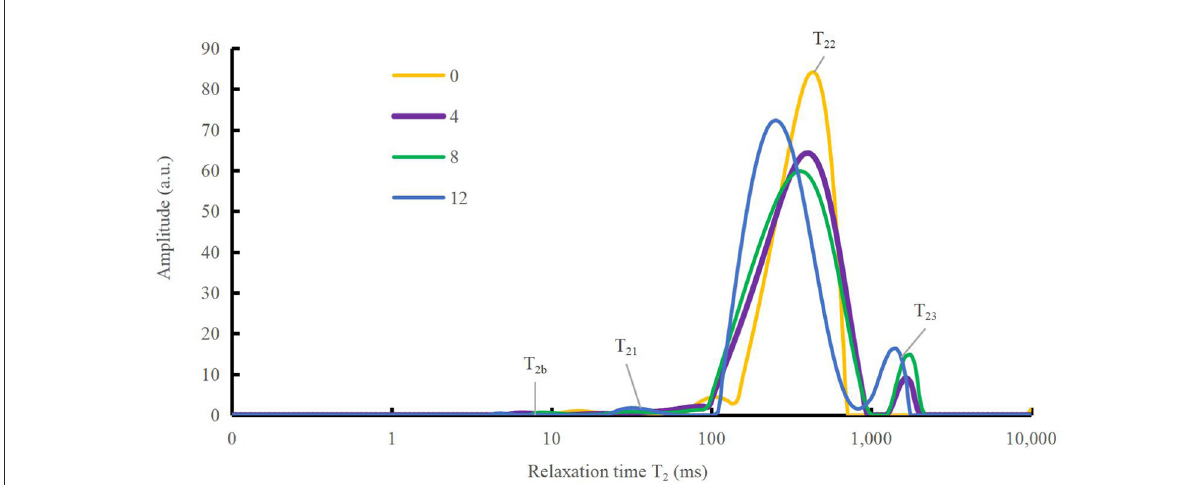
FIGURE4 Variation in spin relaxation time (T 2 ) of water molecules in duck myofibrillar proteins (DMPs) gels pretreated with various hydroxyl radical levels (H 2 O 2 concentrations: 0, 4, 8, 12 mmol/L). T 2b , T 21 , T 22 , and T 23 denote bound, immobilized, moderately immobilized, and free water, respectively.